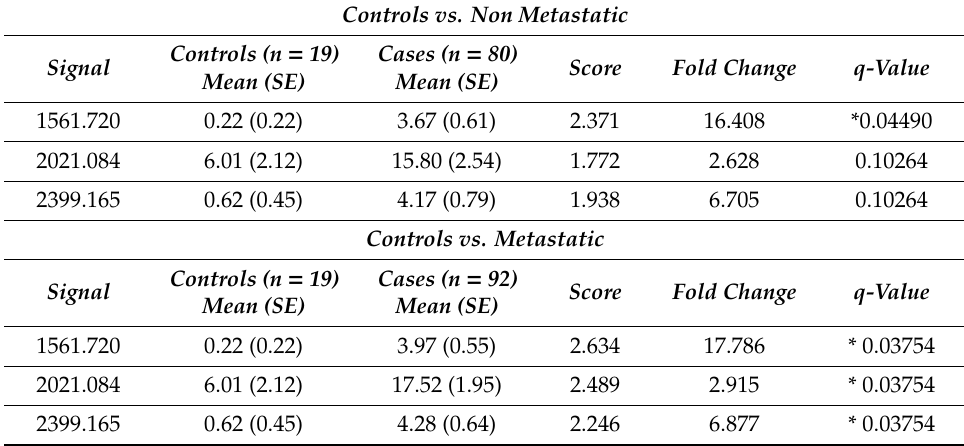
Table 2. Results of significant analysis of microarrays (SAM) analysis on the original dataset. Controls vs. Non